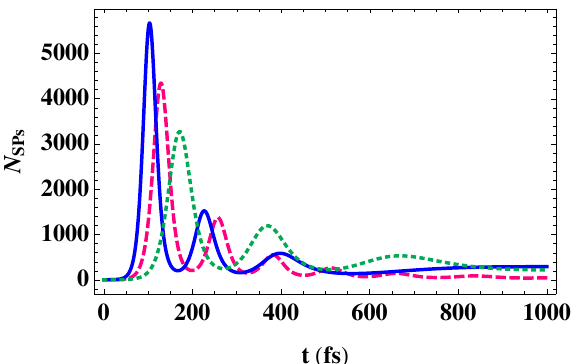
Figure 7. Ultrafast dynamics of the SPs in the proposed MNPs-GNDs-QDs hybrid-system-based spaser with a metallic contact of width W = 0.3 λ 0 , induced by a sech-pulse excitation of wavelength λ 0 = 30 µ m and time duration of ∆ τ = 400 fs (solid), ∆ τ = 600 fs (dashed) and ∆ τ = 2 ps